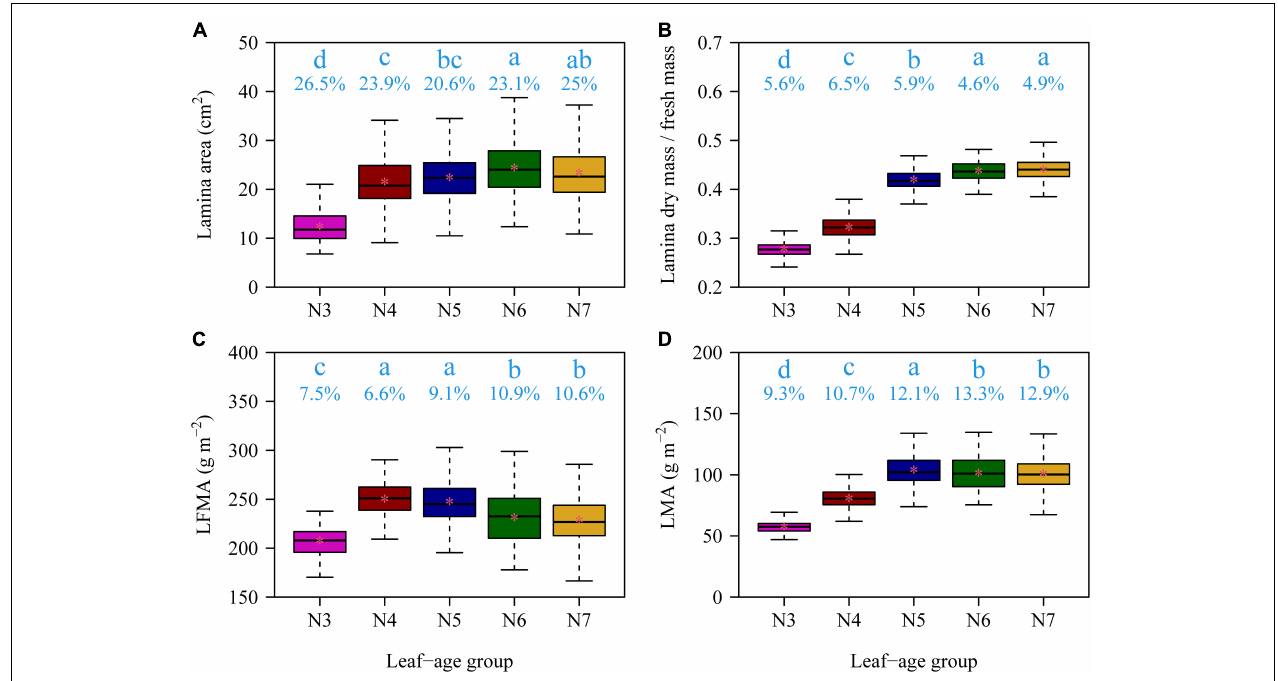
FIGURE 2 | Boxplots of lamina area (A) , the ratio of lamina dry mass to lamina fresh mass (B) , lamina fresh mass per unit area (C) , and lamina dry mass per unit area (D) for the five leaf-age groups. The lowercase letters indicate the significance of the difference between any two of the five groups; the numbers below the lowercase letters are the coefficients of variation. In each panel, there was a significant difference ( p ≤ 0.05) between any two leaf-age groups that did not share the same letter, and there was no significant difference ( p > 0.05) between any two leaf-age groups that shared the same letter based on Tukey’s HST test with the 0.05 significance